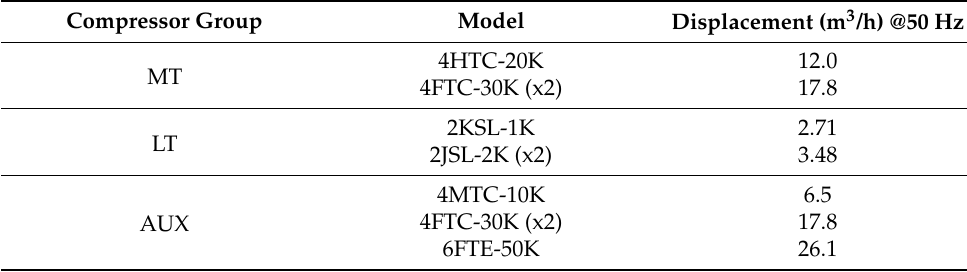
Table 1. Bitzer compressors implemented in the system of the case